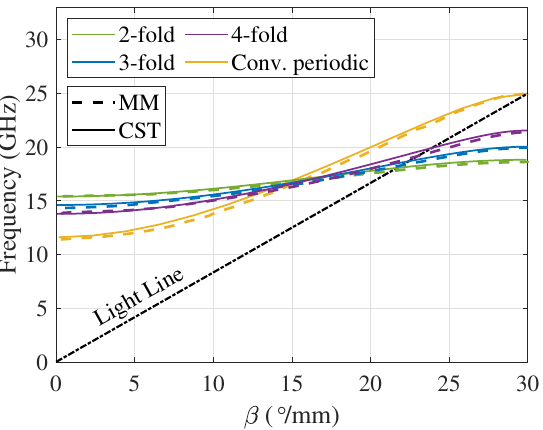
Figure 4. Comparison of the obtained dispersion curves for the studied structures between the mode-matching formulation and CST. The dimensions are: r i = 2mm, r o = 4.7mm, r s = 4.7mm, α = 180 ◦ , and δ = 6mm. In the mode-matching formulation, 1 TEM, 17 TM, and 7 TEmodes are